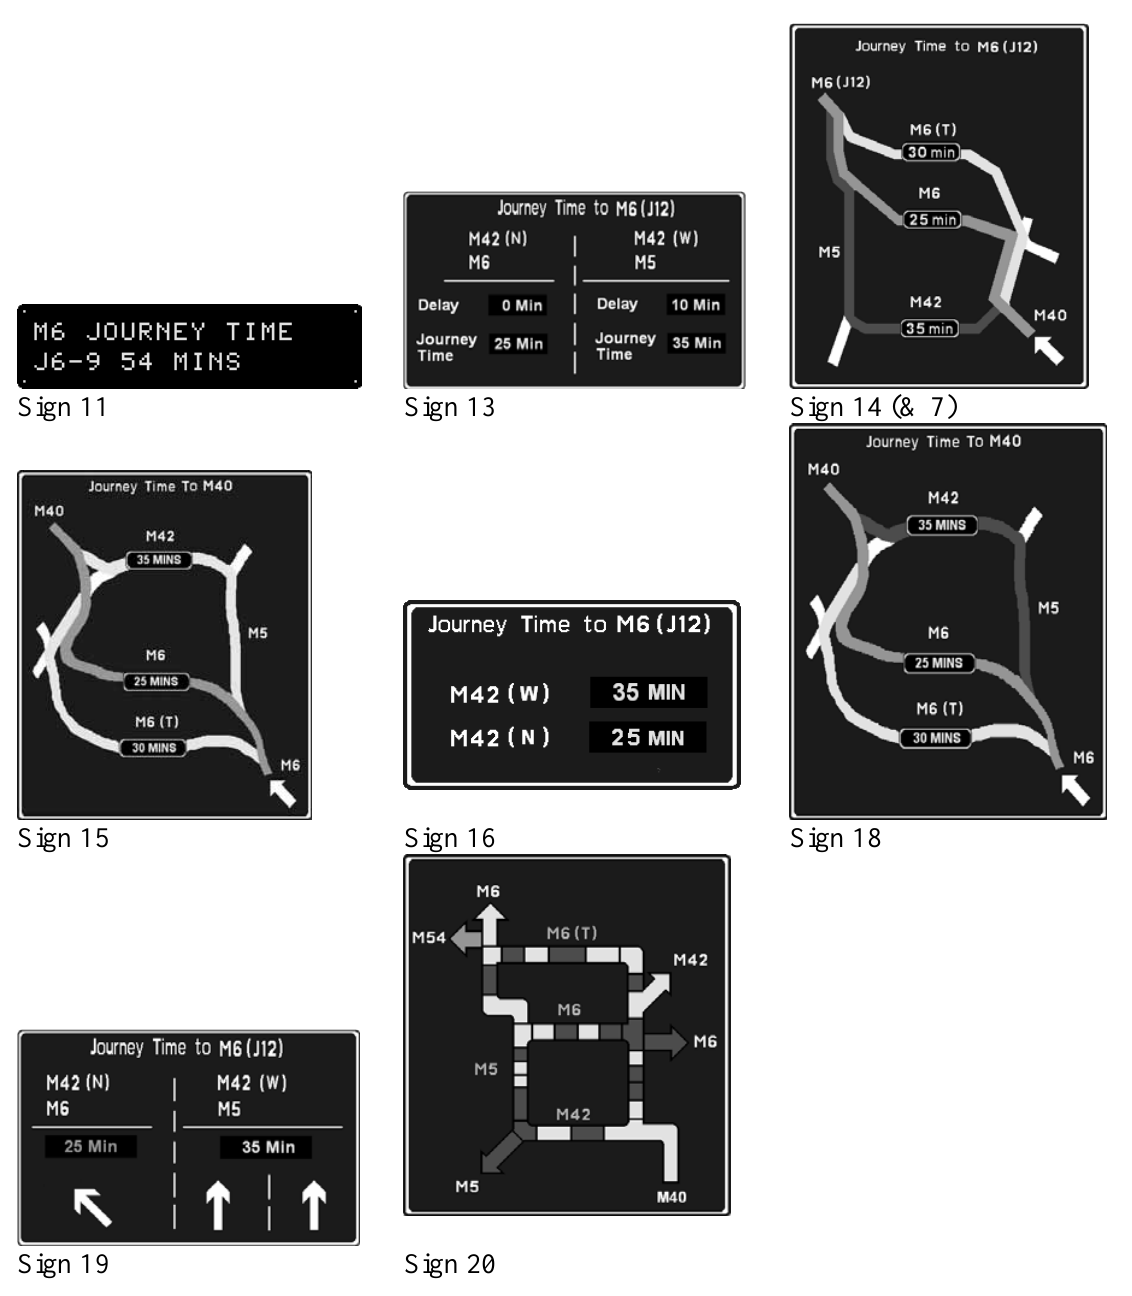
Figure 2b. Sign Designs Used in the Research (continued). 7 is a flashing version of 14. A yellow and green scheme is used in Sign 15, while a yellow, green and red scheme is used in signs 14, 18 and